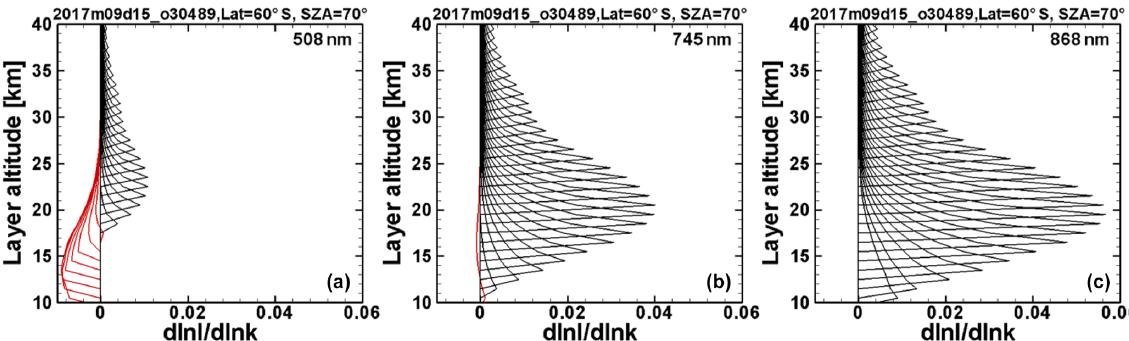
Figure 14. Example of aerosol weighting functions at 60 ◦ S for wavelengths of 508nm (a) , 745nm (b) , and 868nm (c) . Each curve represents the sensitivity of the modeled LP radiance, I , at a given tangent altitude, TH, to a typical aerosol extinction, k , at each 1km altitude layer from 10 to 40km. The weighting functions are positive (black line) and peaked at different altitude ranges. At lower altitudes, the weighting functions at 508 and 745nm become negative (red line) and lose sensitivity to aerosol